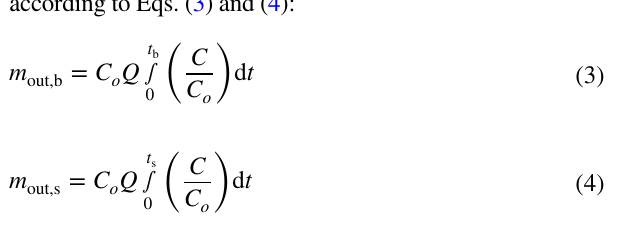
Stock solution of phenol